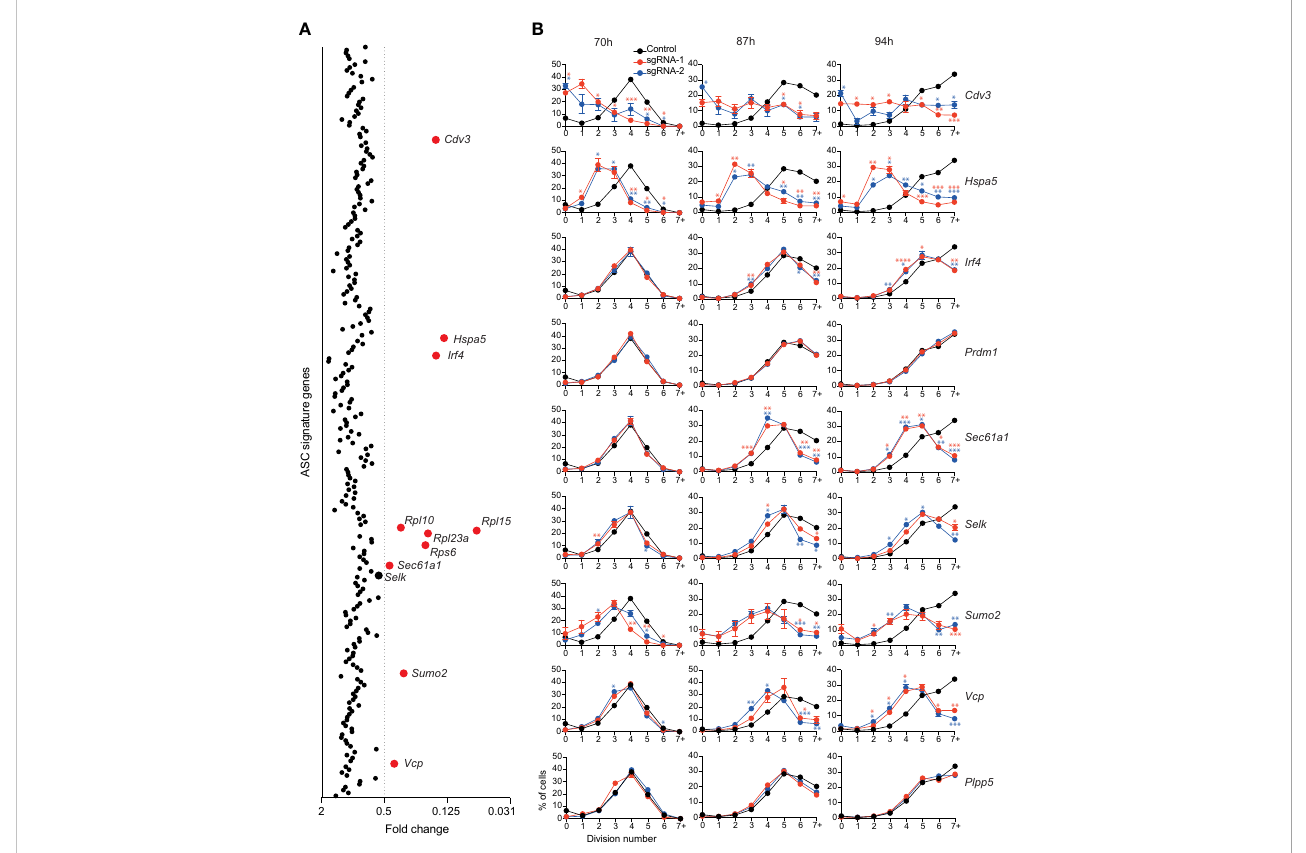
FIGURE 3 Genes affecting total live cell number. (A) Experimental work fl ow is described in Figure 1A. Average fold changes in the total number of live cells for each targeted gene relative to the untransduced control. Genes with a fold change of ≤ 0.5 are labelled and highlighted in red. Data points represent the mean of 2 independent sgRNAs from 2 replicate experiments. (B) Naïve B cells from Cas9 transgenic mice were labelled with the division tracking dye CTY, activated with LPS and transduced with sgRNAs targeting Irf4 , Prdm1 , Cdv3 , Sumo2 , Sec61a1 , Hspa5 , Selk, Vcp or the Plpp5 control. At the indicated timepoints, the dilution of CTY was assessed by fl ow cytometry. Data points represent the mean proportion of cells in each division from triplicate wells. Error bars indicate the S.E.M. Representative of 3 independent experiments. *p < 0.05, **p < 0.01, ***p < 0.001, ****p <